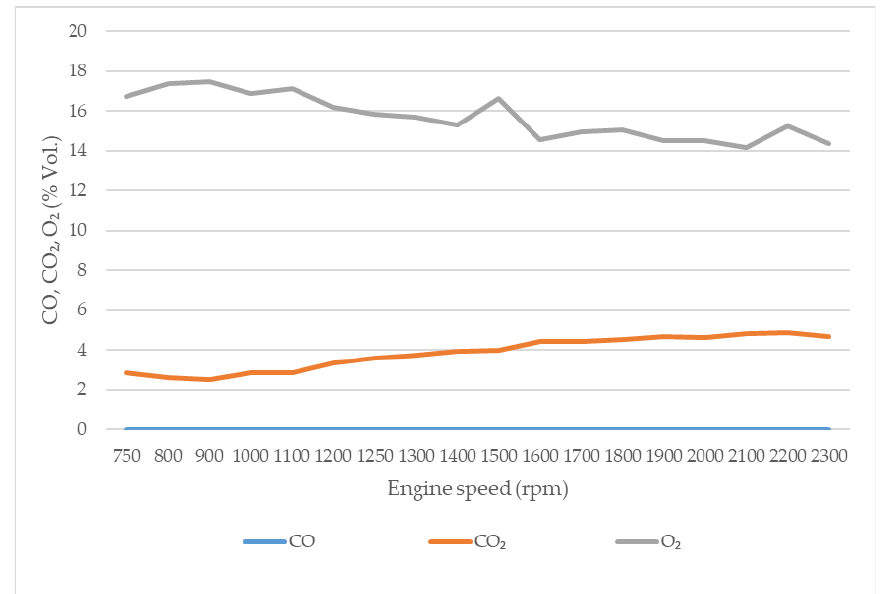
Figure 3. Changes in CO, CO 2 , and O 2 in relation to the engine speed.